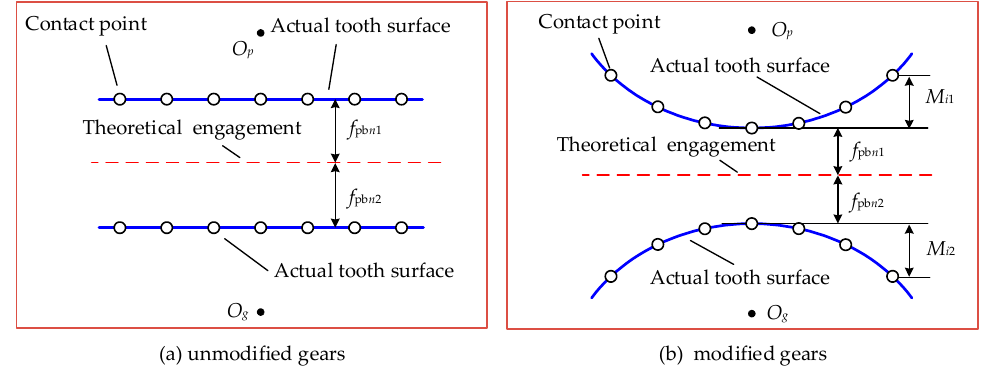
Figure 4. Initial contact condition before load in consideration of cumulative pitch deviations.